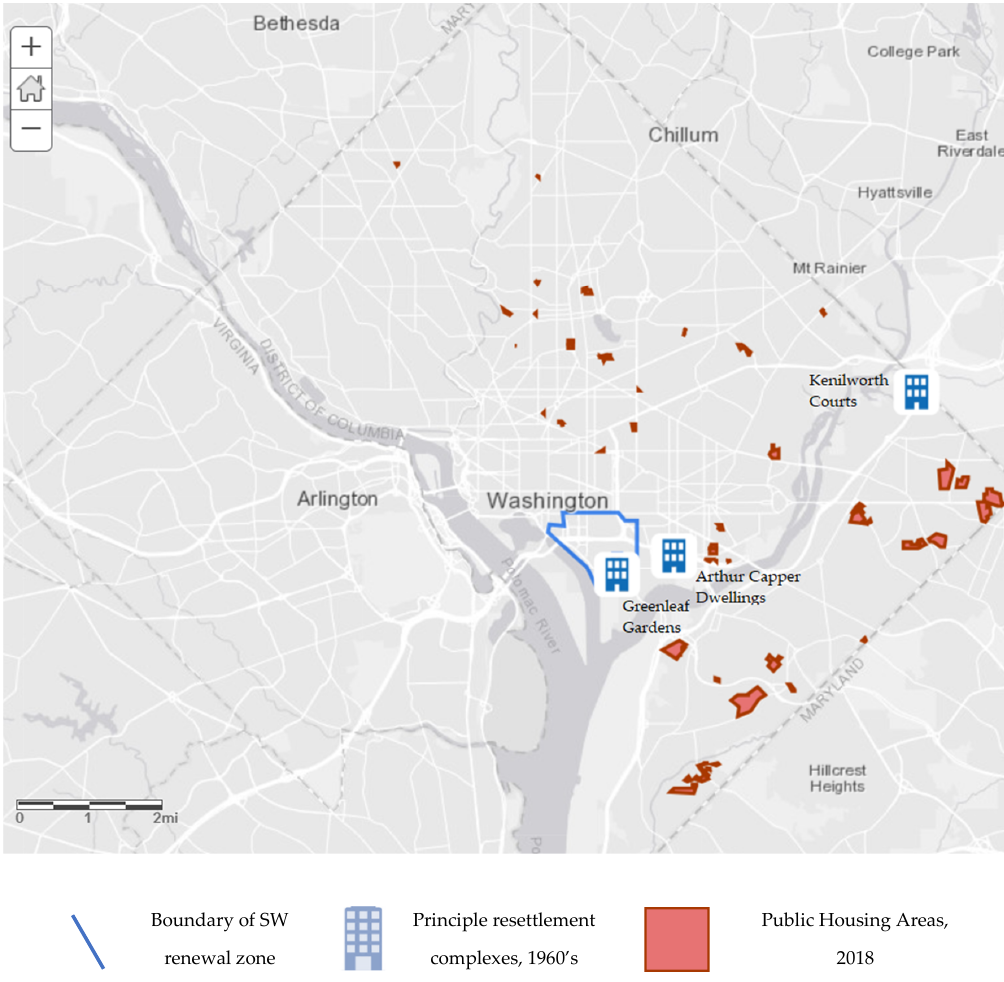
Figure 2. Overlay of (left to right) Greenleaf Gardens, Arthur Capper Dwellings, and Kenilworth Courts with additional present-day public housing areas, predominantly in Washington’s east and south quadrants. Source of 2018 public housing areas: